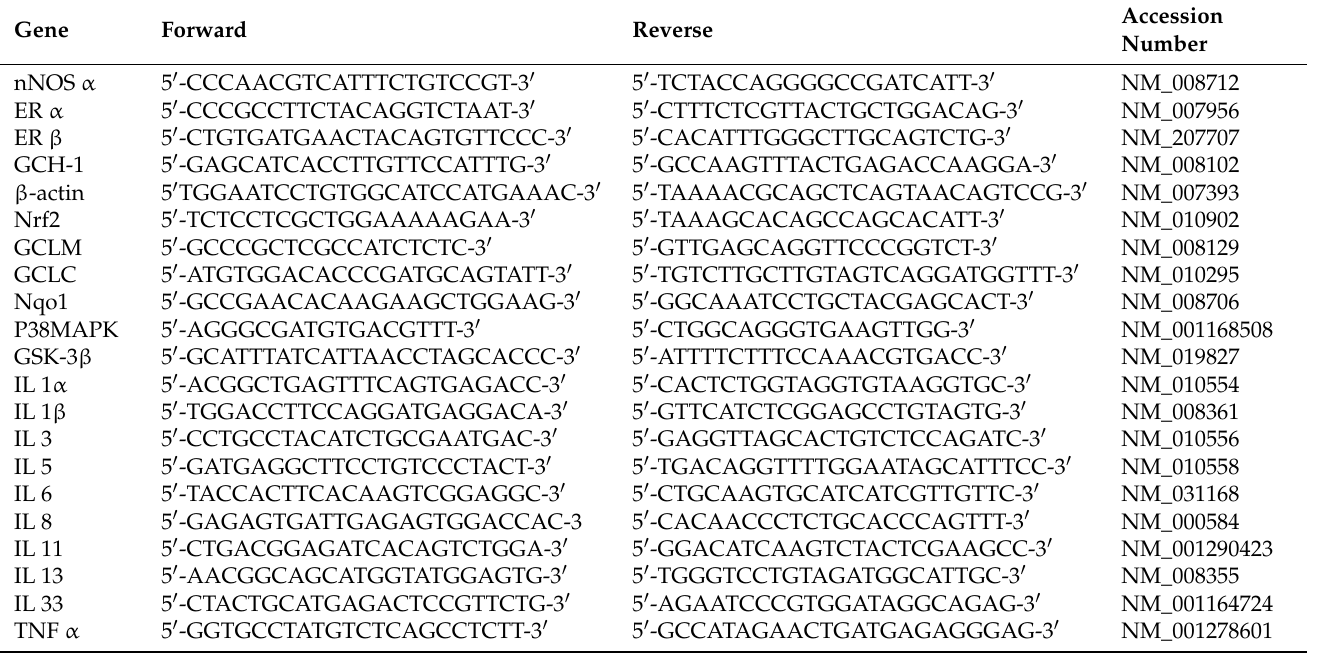
Table 1. Primer sequences for